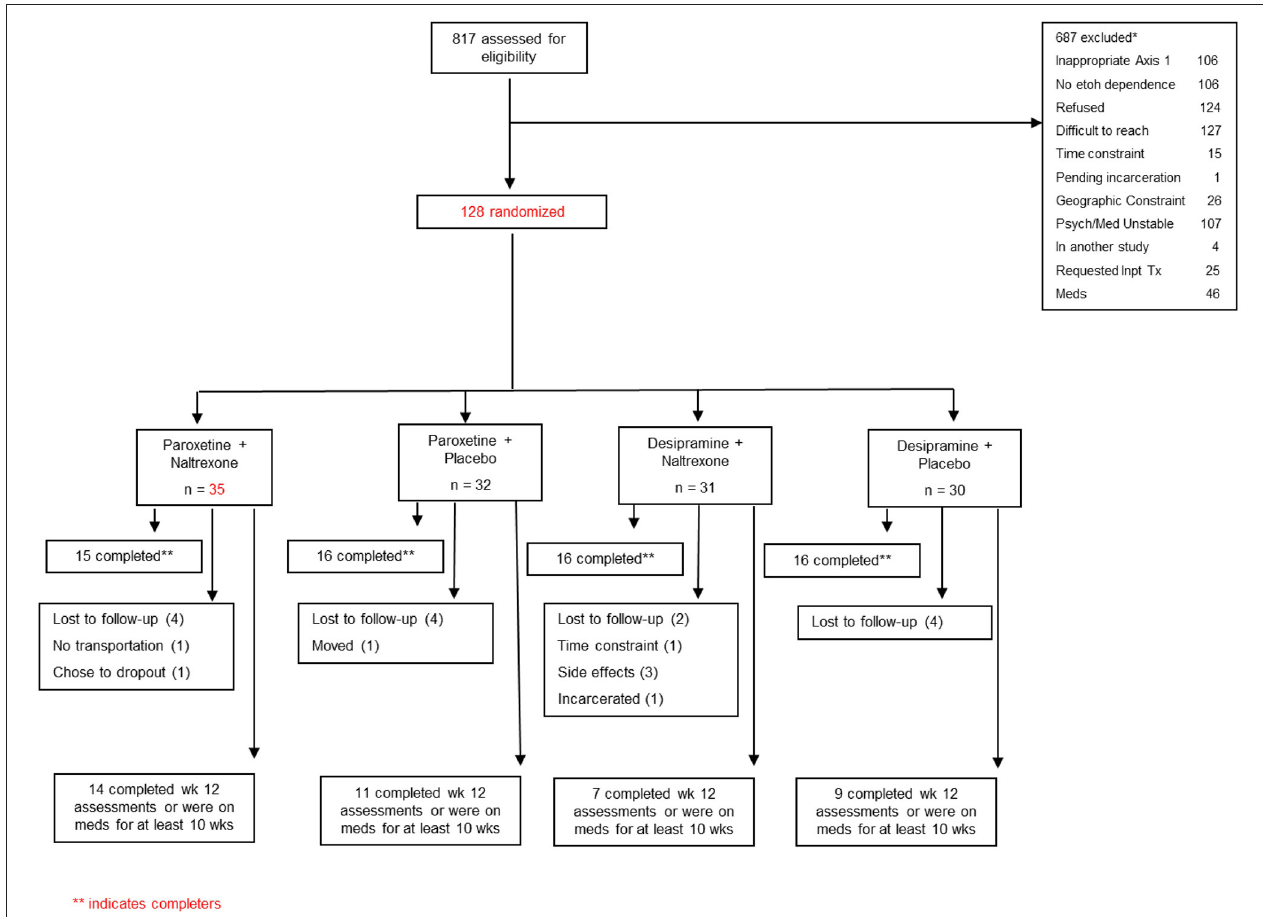
FIGURE 1 | Flowchart describing the screening and randomization distribution for the participants in the study.